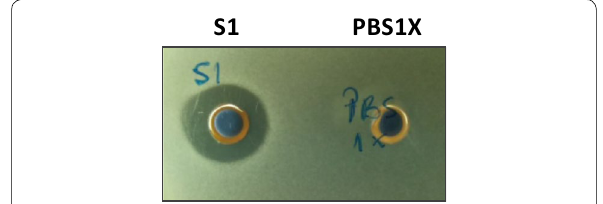
Fig. 1 Antimicrobial activity of Lactobacillus acidophilus KS400 bacteriocin against Lactobacillus delbrueckii ATCC9649. Culture extracts of Lactobacillus acidophilus KS400 tested by the agar well diffusion method described (Tagg and McGiven 1971). S1—culture medium from Lactobacillus acidophilus KS400 medium; PBS 1X— negative control corresponding to 1 phosphate buffered saline ×